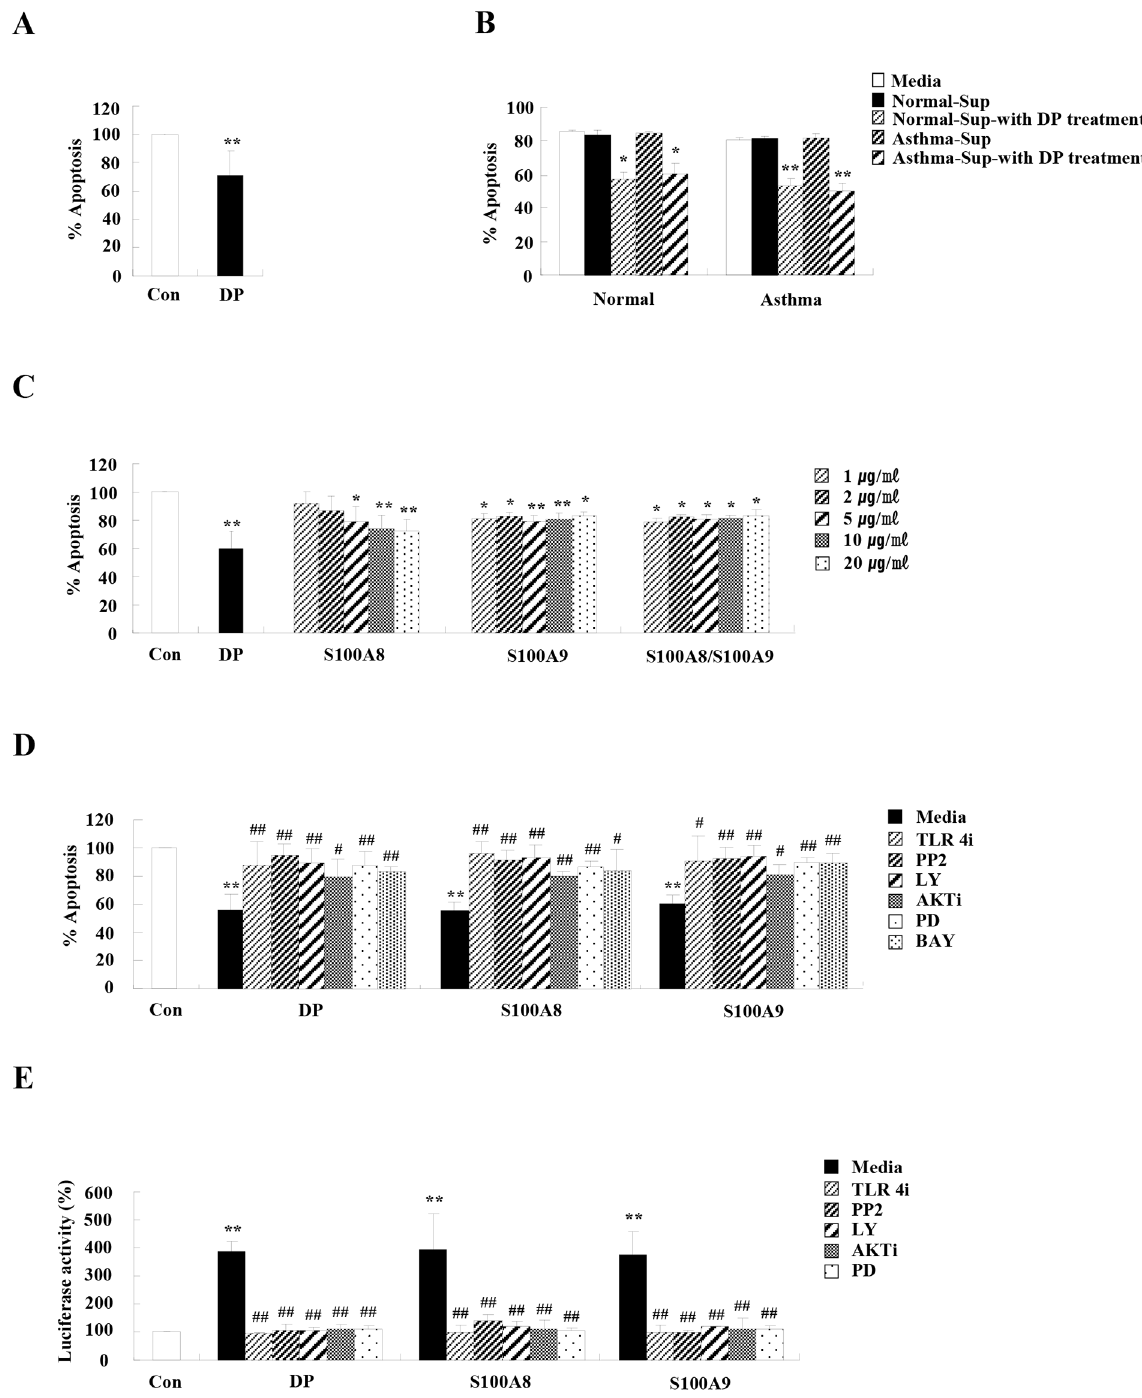
Fig 5. DP, S100A8, and S100A9 have anti-apoptotic effects in asthmatic neutrophils. (A-E) (A) Neutrophils were isolated from the peripheral blood of asthmatic subjects (n = 54). The cells were incubated for 24 h in the absence (Con) and presence of DP (10 μ g/mL) (B) Normal and asthmatic neutrophils were incubated with and without 10 μ g/ml of DP for 24 h. The supernatant (Sup) was collected and added to the fresh neutrophils isolated from the peripheral blood of normal and asthmatic subjects (n = 9). (C) Asthmatic neutrophils (n = 3) were incubated for 24 h in the absence (Con) and presence of S100A8 and S100A9 in the indicated dose. (D) Asthmatic neutrophils (n = 3) were pre-treated for 1 h with and without 1 μ M TLR4i, 10 μ M PP2, 10 μ M Ly294002 (LY), 10 μ M AKTi, 10 μ M PD98059 (PD) and 10 μ M BAY-11-7085 (BAY), after which the cells were incubated for 24 h in the absence and presence of S100A8 and S100A9 (10 μ g/ml). Apoptosis was analyzed by measuring the binding of annexin V-FITC and PI. Data are expressed as the means ± SD and are